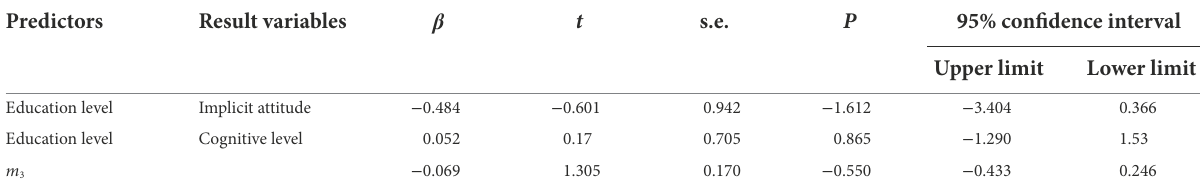
TABLE 6 Mediating effect analysis